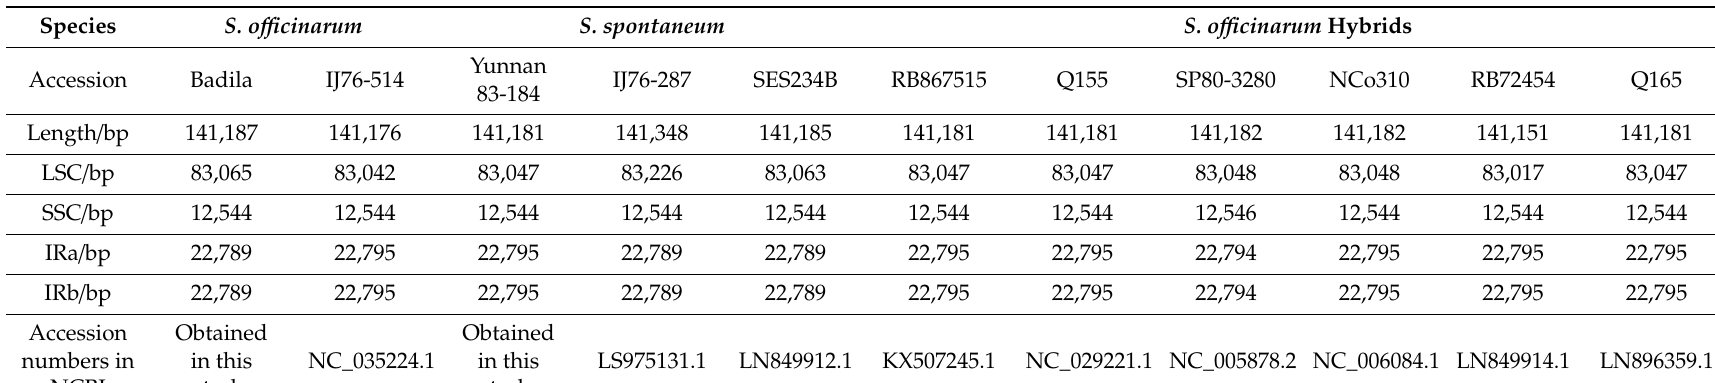
Table 6. The structure and length of the chloroplast genome sequences in sugarcane hybrids and their ancestors Saccharum o ffi cinarum and S. spontaneum .